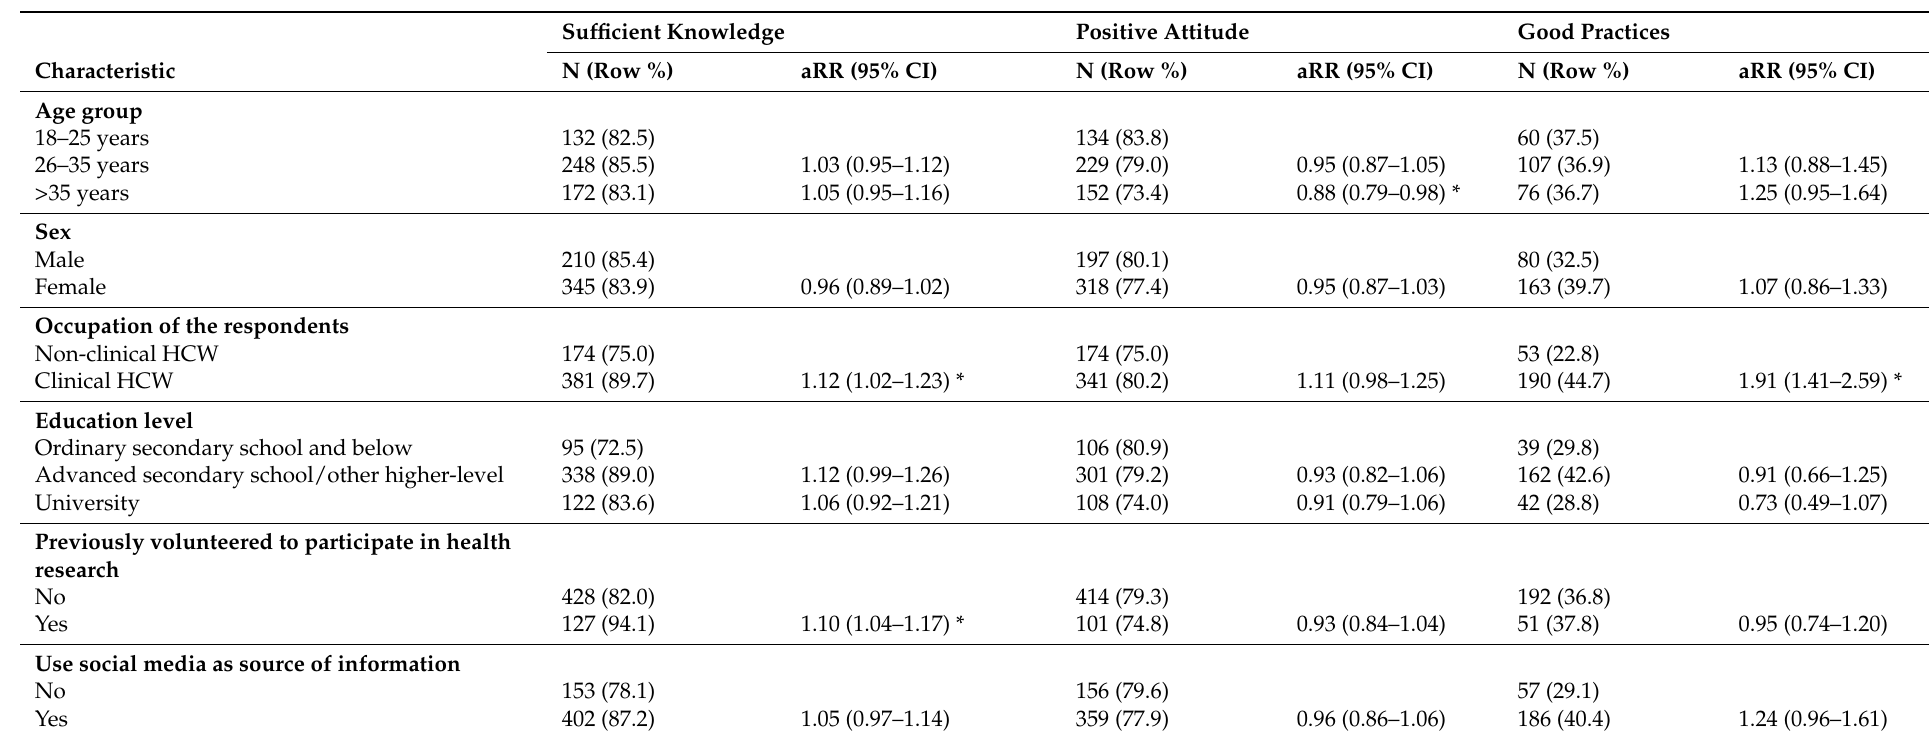
Table 5. Factors associated with knowledge, attitude and practice toward COVID-19 among healthcare workers in Uganda. Sufficient